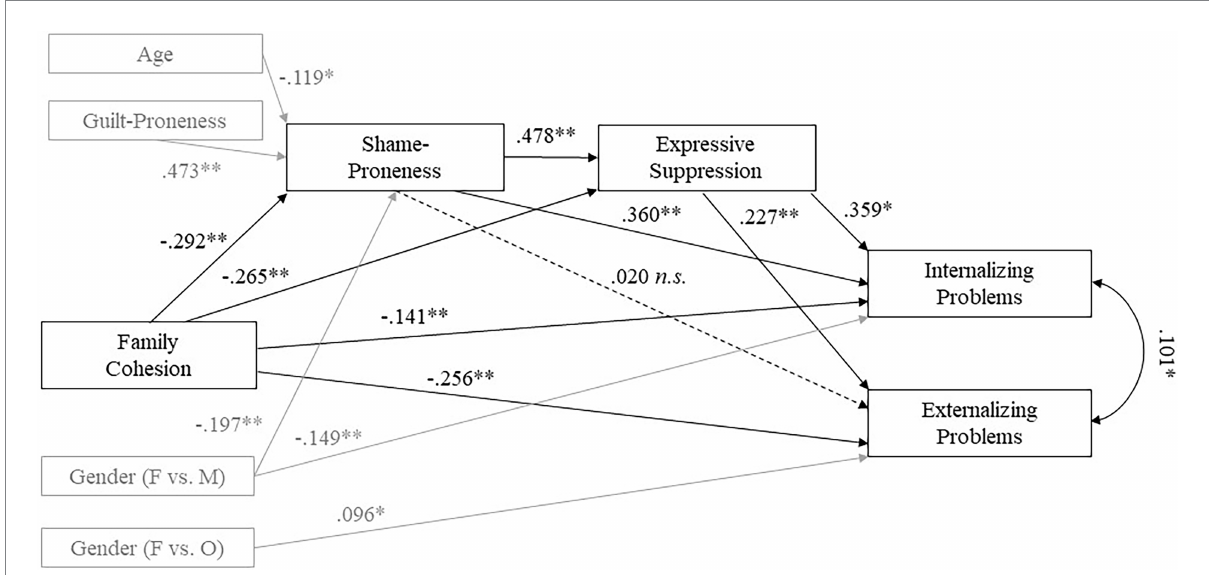
FIGURE 2 Statistical model with standardized path coefficients. Standardized path coefficients are shown. Control variables and their significant paths are displayed in gray; non-significant paths of the control variables are not displayed. * p < 0.05; ** p <